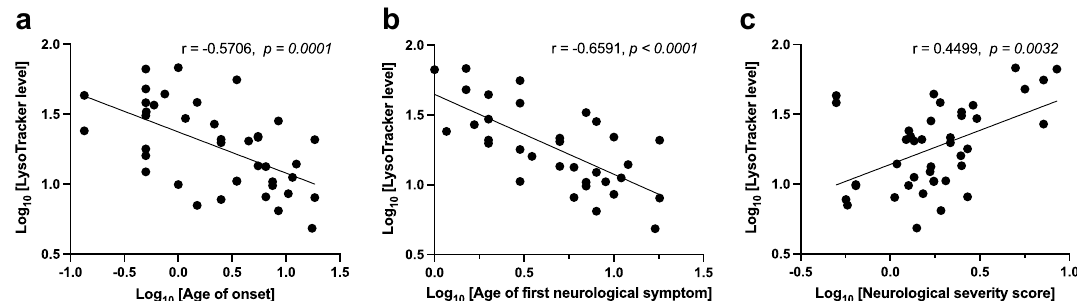
Figure 2. Fibroblasts from individuals with NPC1 disease show LysoTracker staining that significantly correlates with age of onset and disease severity. ( a ) LysoTracker level, measured as fold-change increase over background, is inversely correlated with the age of symptom onset. These age of onset data points included any NPC1-associated phenotypes, such as hepatosplenomegaly, jaundice and neurological abnormalities. ( b ) LysoTracker level also shows inverse correlation with the age of first neurological symptom, and this correlation is greater than that seen for any symptom onset. ( c ) LysoTracker level correlates with the age-adjusted neurological severity score (see “Materials and methods” section for score description). For all 3 graphs, each point represents a single NPC individual, and log 10 -transformed values are presented and were used for statistical analyses. P values indicate significant correlation using Spearman’s correlation; lines were calculated using simple linear